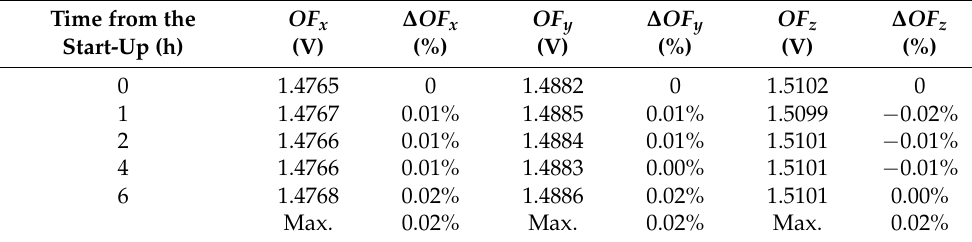
Table 6. Offset variations within six hours.